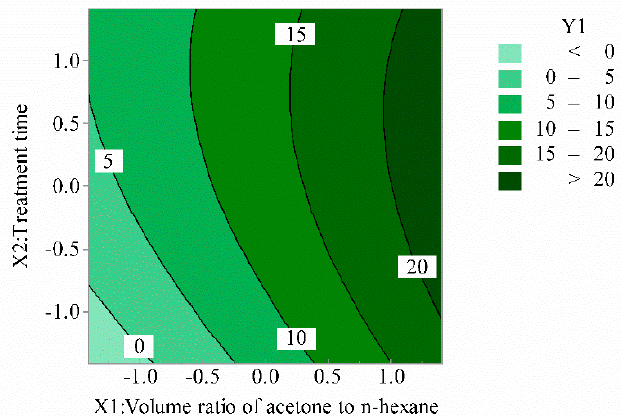
Figure 3. Volume ratio of acetone to n-hexane and treatment time for illumination intensity (2D).